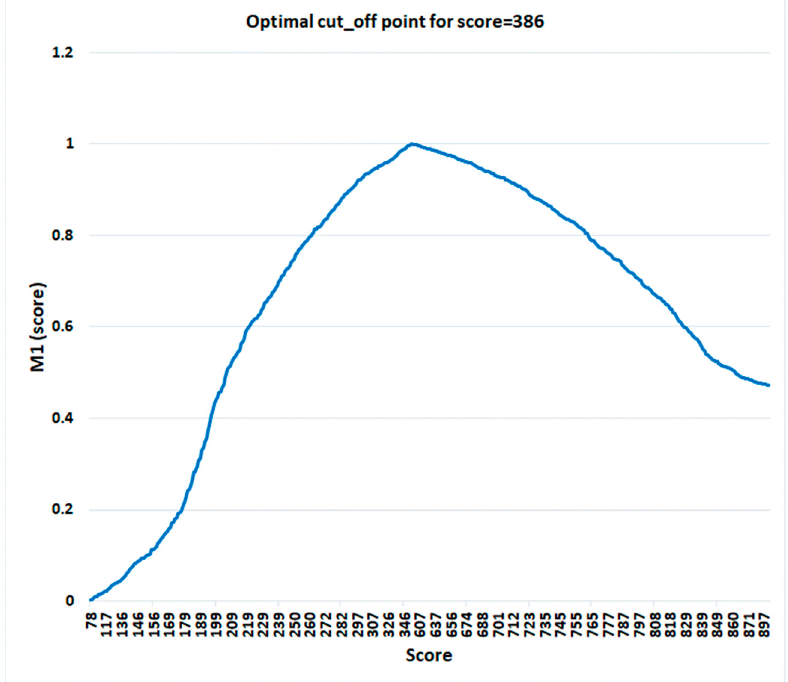
Figure 13. Optimal score cut-off point for the GBM model. Source: own elaboration using Excel. 5.6. Classification of Enterprises from the Podkarpacie Region (Prediction Stage) Depending on the Risk of Their